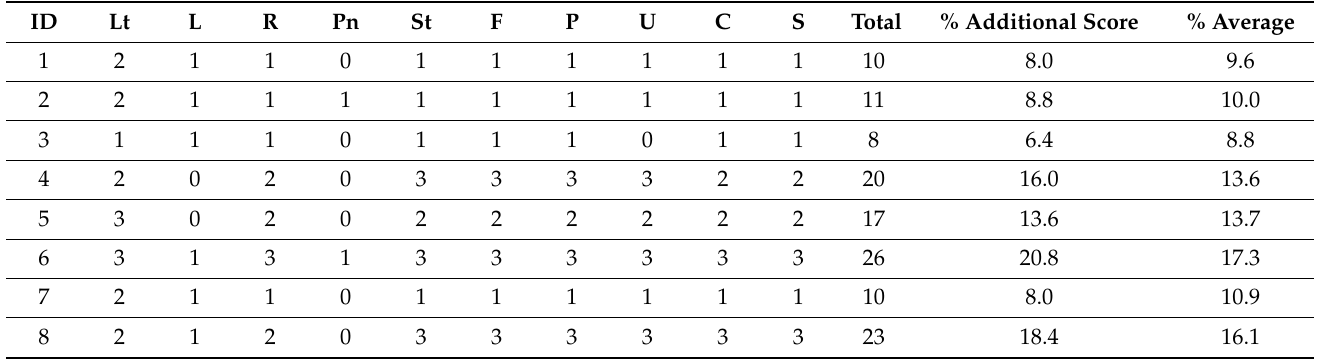
Table 2. Additional parameters for tool